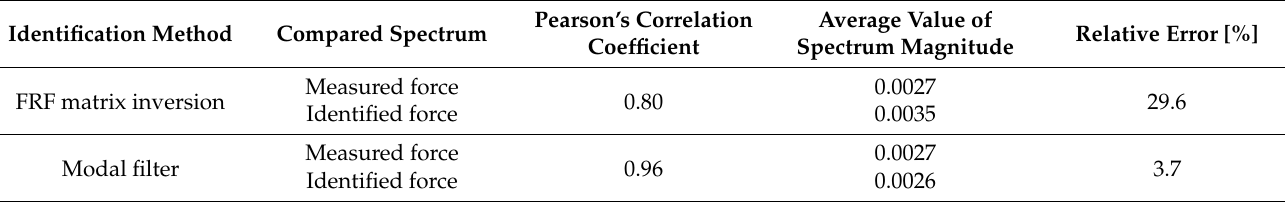
Figure 8. Comparison of measured (solid black line) and identified (dotted red line) force spectra— zoomed frequency range (FRF matrix inversion method). Table 2. Quantitative assessment of the considered force identification methods.